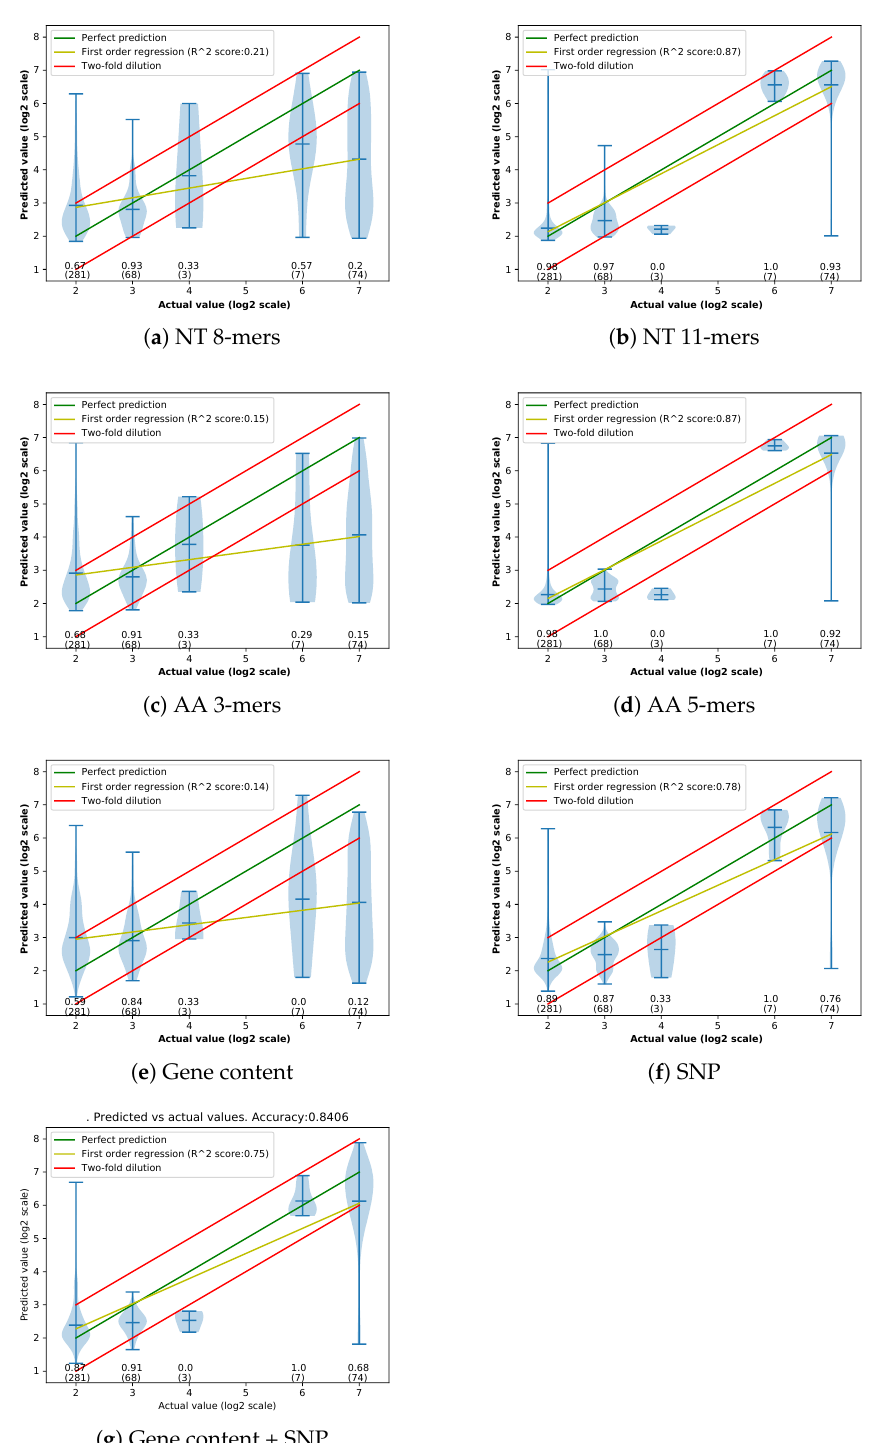
Figure A6. Violin plots of performances of different methods in predicting MIC of nalidixic acid for C. jejuni . X-axis is the actual value and y-axis is the predicted value. Each violin shows the kernel density estimation distribution of predictions for one target value. Below each violin, the ± 1 two-fold dilution accuracy of that target value is mentioned, and below that, the number of strains with that target value is mentioned in parentheses. The green line represents the perfect prediction and the yellow line represents the first order regression between the actual values and predicted values. The red lines represent the limits of ± 1 two-fold dilution. ( a ) NT 8-mers, ( b ) NT 11-mers, ( c ) AA-3mers, ( d ) AA-5mers, ( e ) gene content, ( f ) SNP, ( g ) gene content +